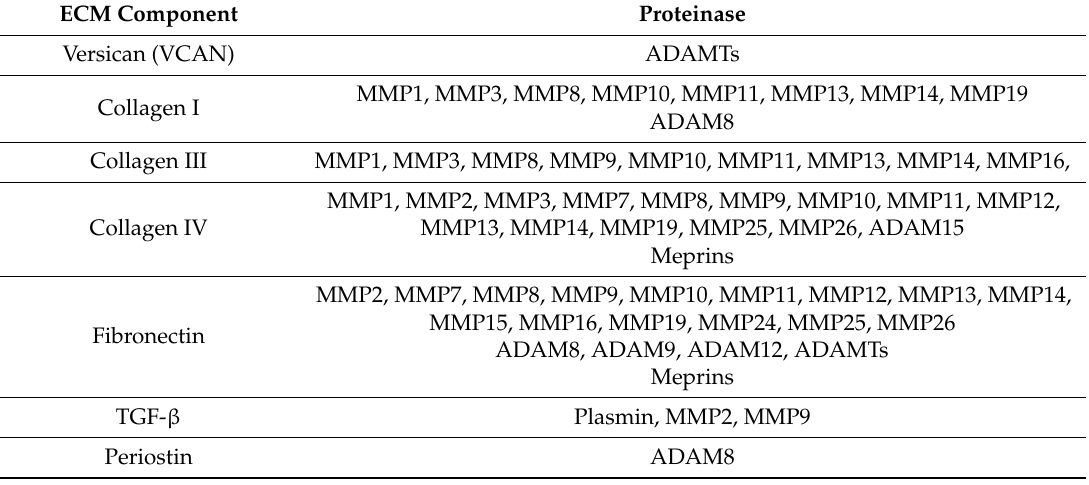
Table 1. Major ECM components involved in pre-metastatic niche formation in lung, liver and bone that are proteinase